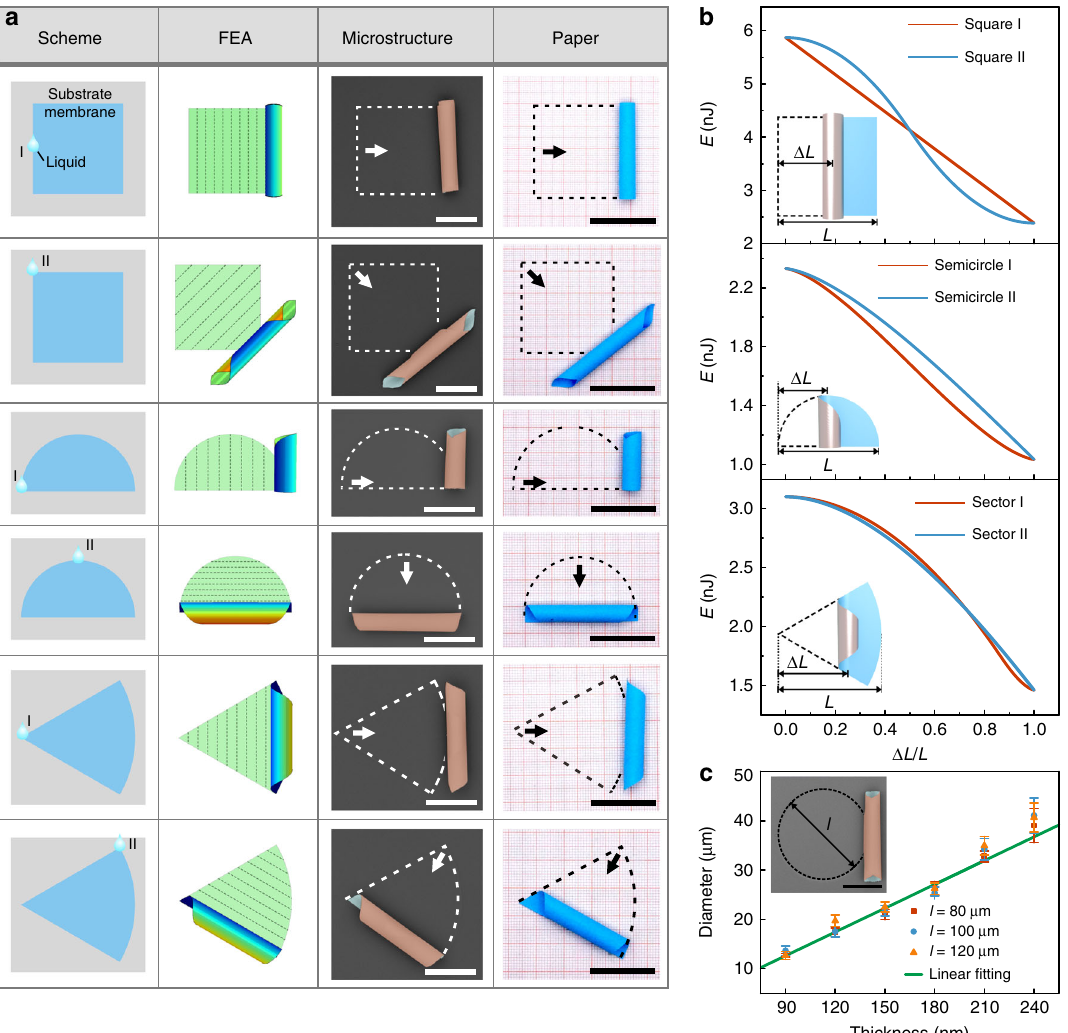
Fig. 2 Microdroplet-guided construction of tubular microstructures. a The scheme of square, semicircle, and sector-patterned nanomembrane with different microdroplet trigger point, FEM predictions, experimental results (SEM images), and corresponding paper works (photographs) of six different tubular microstructures. Dashed lines in the FEM model elucidate the sketch of partition in the quasi-static model. Scale bar (third column), 50 μ m. Scale bar (forth column), 3 cm. b Calculation results in total elastic energy change during different rolling routes of square, semicircle, and sector pattern design. The insets illustrate the geometric parameters released length Δ L and total released length L . Elastic energy is relaxed slightly differently because of different released behaviors. c The diameter of tubular microstructures related to the pattern size and total thickness. The inset is the SEM image of rolled- up microtubes with circle pattern, of which diameter is de fi ned as l . Scale bar, 50 μ fi tting was applied as the green line in Fig. 3b and it matches well with experimental results. Therefore, it is proved that the size of microstructures can be tuned by deposition parameters and designed with theoretical calculation.